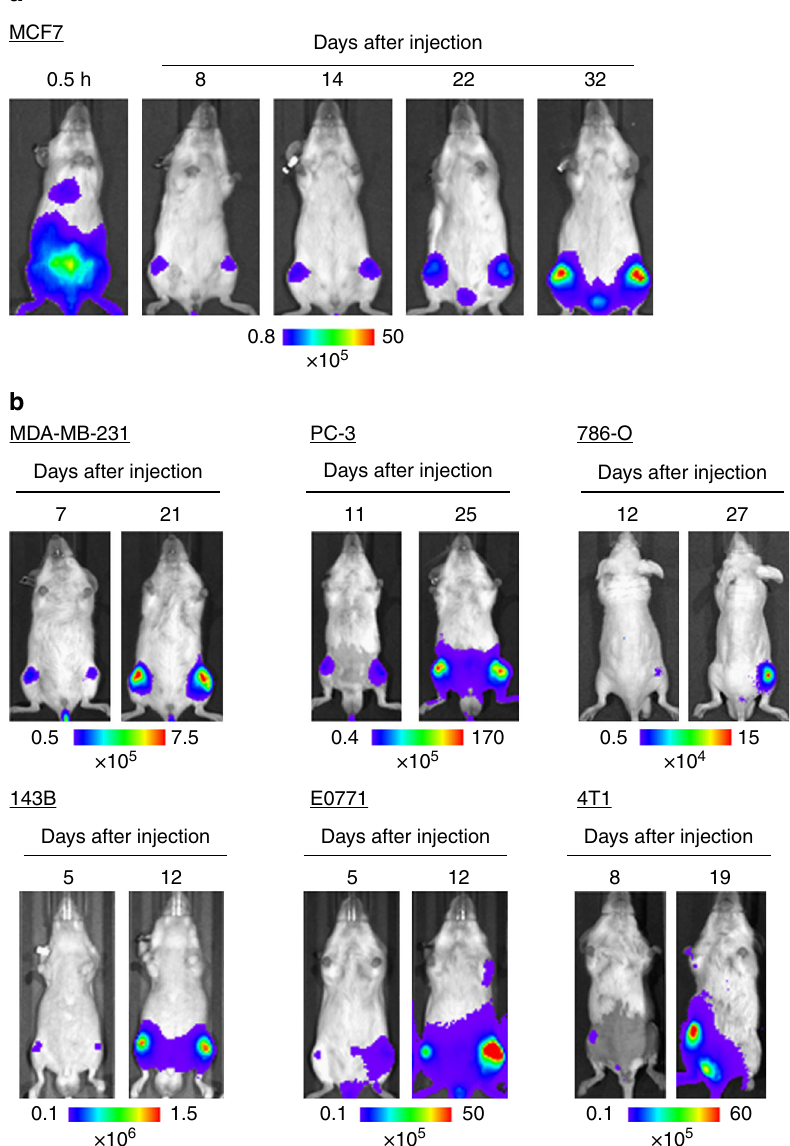
Fig. 4 Ef fi cient bone metastasis development with various cancer cell lines by CA injection. a Representative BL images at indicated days after CA injection of MCF7 constitutively expressing fi re fl y luciferase. b Representative BL images at indicated days after CA injection of cancer cell lines (MDA-MB-231, PC-3, 786-O, 143B, E0771, and 4T1) constitutively express fi re fl y